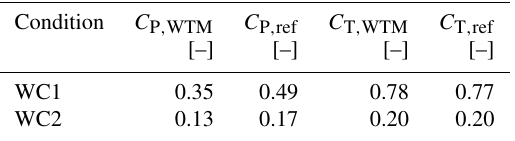
Table 4. Steady power ( C P ) and thrust ( C T ) coefficient for the wind turbine model (subscript “WTM”) and for the IEA 15MW (sub- script “ref”) in the operating conditions of the experiment (see Ta- ble